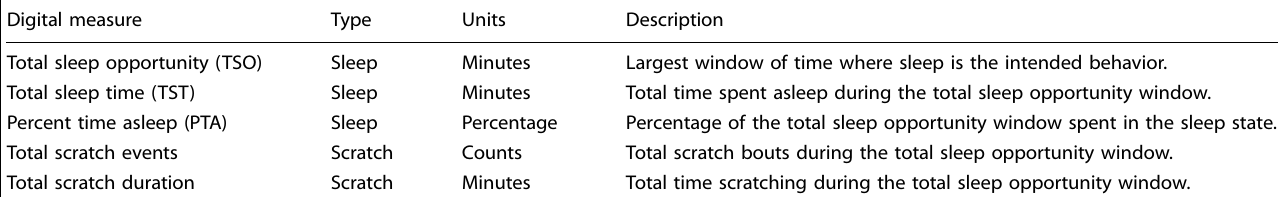
Table 4. Description of digital measures output from the analytics solution. Digital measure